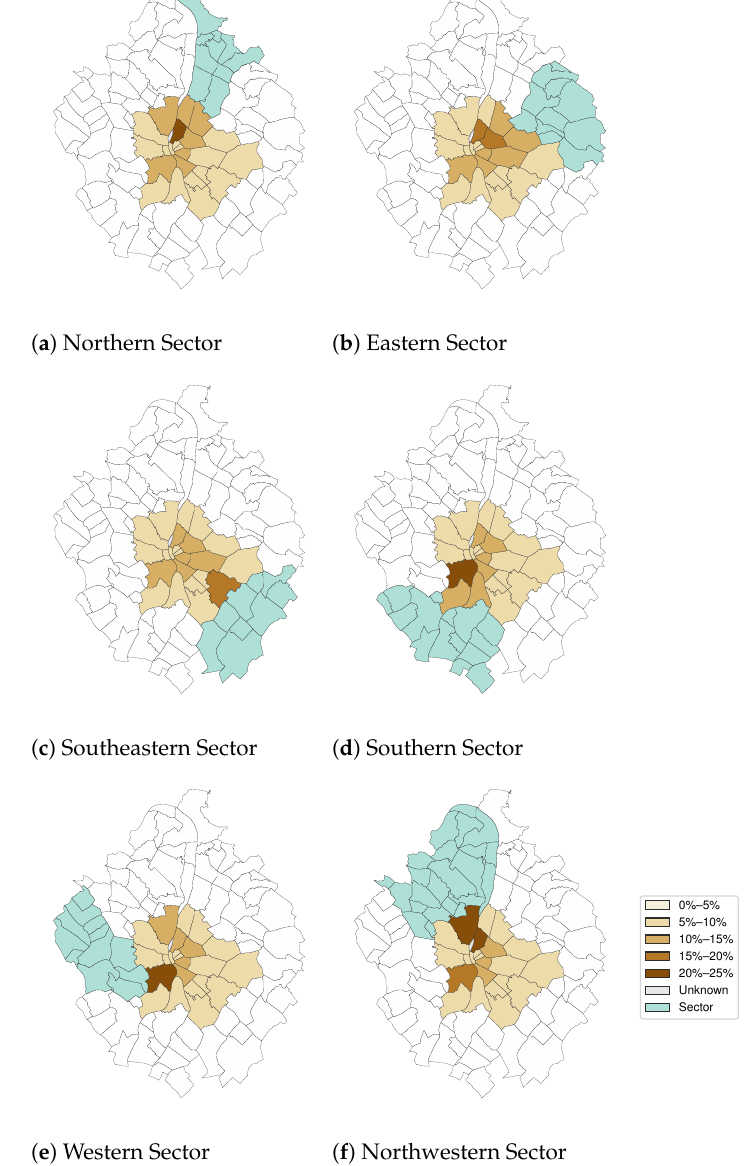
Figure 13. Commuting from the six sectors of the urban agglomeration, based on CDR